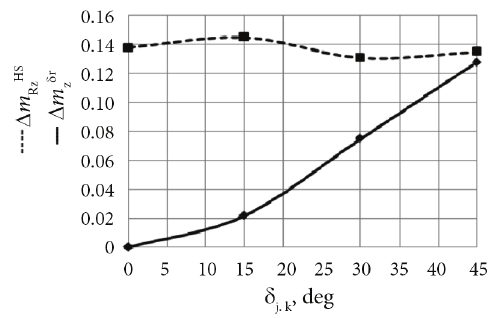
and δ r as function of δ zHS m z m